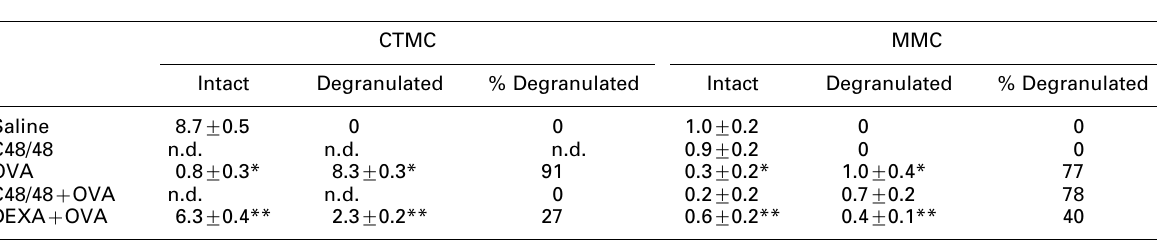
Table 2. Cumulative data for mast cell numbers in rat distal trachea